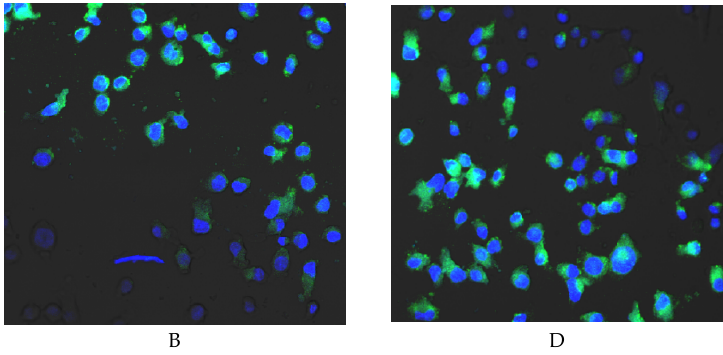
Figure 8. Imaging of COX-1 enzyme expression by fluorescence microscopy in THP-1 monocytes cultured with Biodentine TM . Cells were cultured in RPMI medium with 10% FBS—control condition for 24 h ( A ) and for control condition for 48 h ( B ); THP1-monocytes cultured in RPMI medium with 10% FBS with Biodentine TM for 24 h ( C ) and for 48 h ( D ). The immunohistochemistry was performed using specific primary antibody, mouse anti-COX-1 (the overnight incubation at 4 °C) and secondary antibodies conjugated with fluorochrome—anti-mouse IgG-FITC (fluorescein isothiocyanate) (incubation for 45 min at room temperature), enzyme expression visible as green fluorescence indicate COX-1 expression. The nuclei of cells were 4′,6-diamidino-2-phenylindole (DAPI) stained. Image analysis was performed with a confocal microscope using filters 38 HE GFP for green fluorescence and 49 DAPI for blue fluorescence. Objective magnification 20×, computer zoom 2×. Experiments were conducted as six separate assays (each assay in three replicates). No differences in enzymes protein expression were observed, p ≤ 0.5 (U Mann-Whitney test).